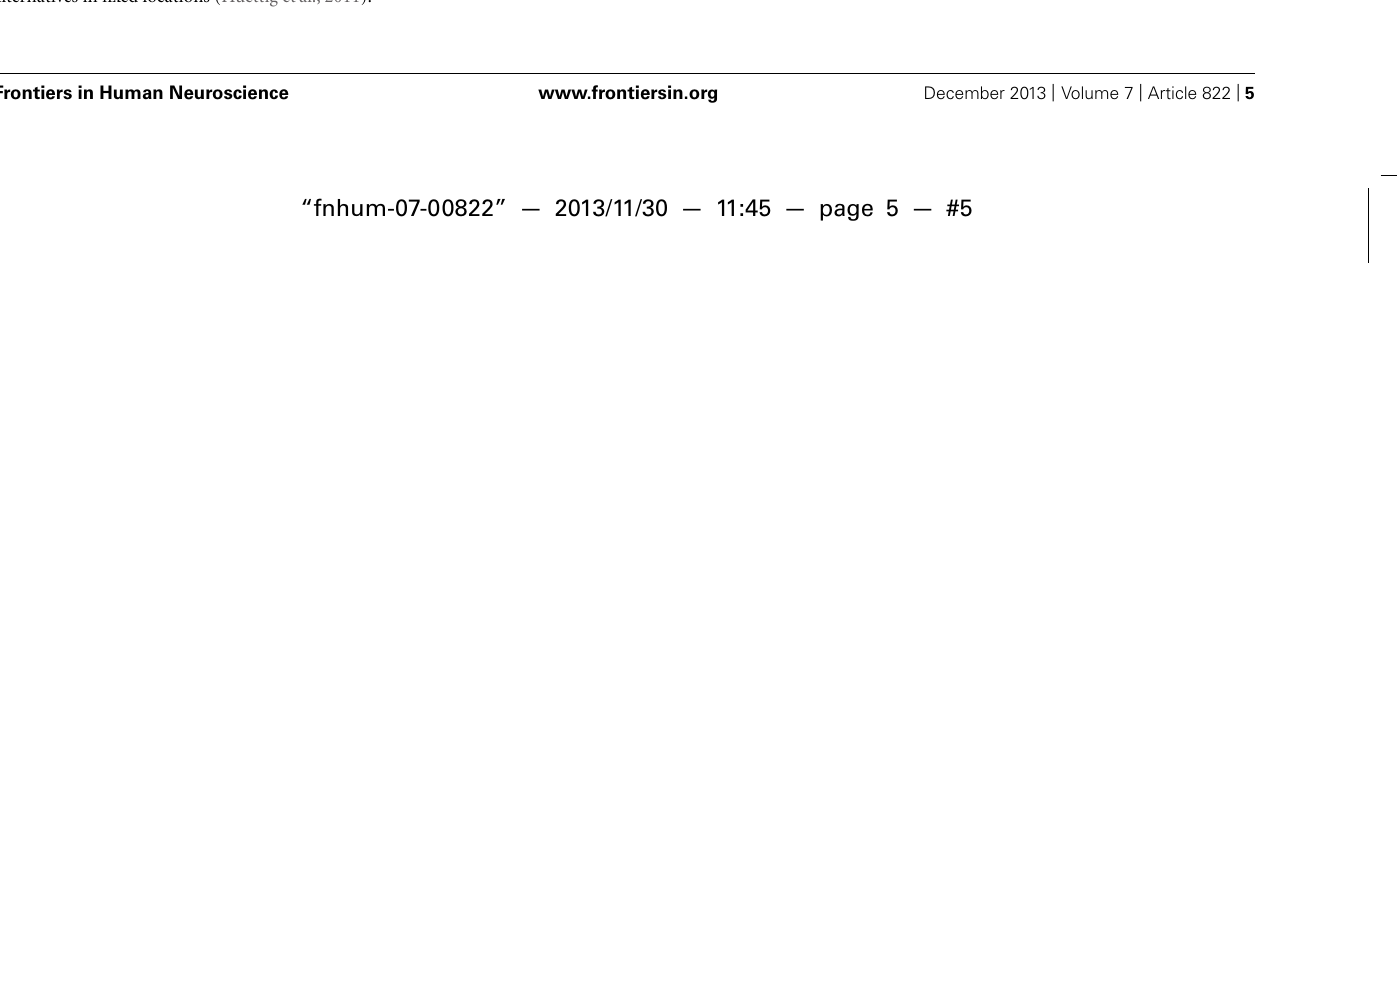
by-Competition interaction). Observed data (points) and model predictions (curves), with the colored bands surrounding each curve representing ± 1 SE, and the shaded bars representing 95% confidence intervals for effect onsets. The leftmost bar in each plot corresponds to onset of the competition effect, while the rightmost bar reflects the onset of cultural